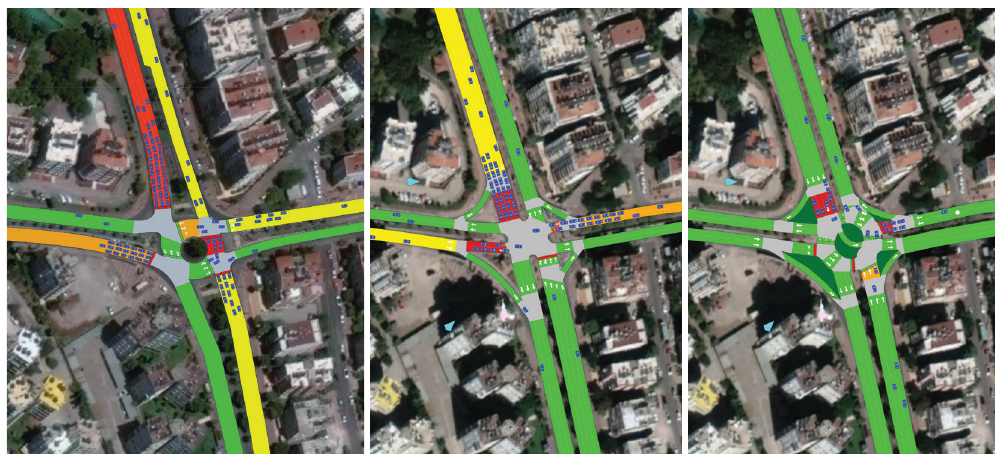
Figure 17. Coloured simulation images for the roundabout status in 2016, in the current status and the image as per the proposed roundabout (by